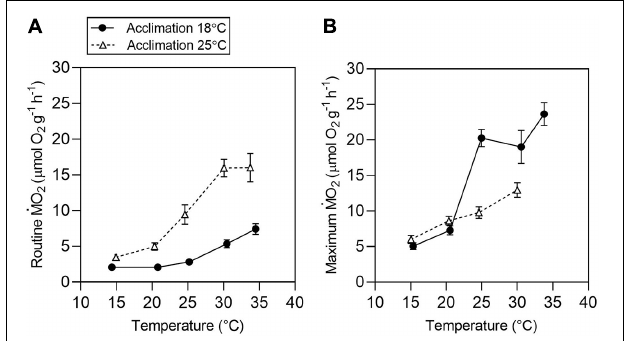
FIGURE 3 | Temperature effects on aerobic metabolism in tadpoles of Bokermannohyla ibitiguara . Mass-specific routine [ (A) r ˙ MO 2 ] and maximum [ (B) m ˙ MO 2 ] metabolic rates for tadpoles acclimated to 18 ◦ C ( N = 8) and 25 ◦ C ( N = 8) and exposed to different test temperatures (15, 20, 25, 30, and 34 ◦ C). Data are presented as mean ± s.e.m.